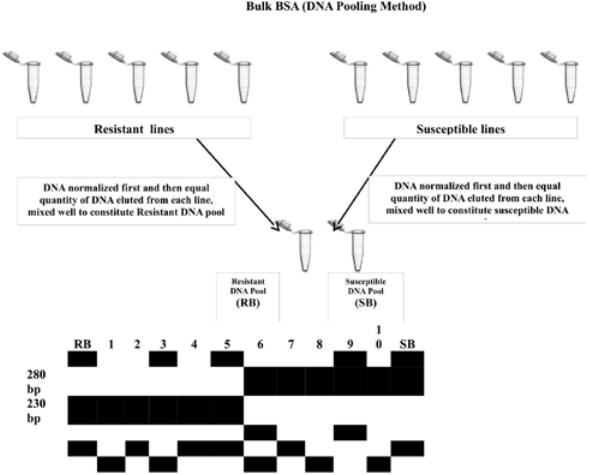
Figure 1. Figure depicting bulking sampling method where equal amount of DNA is eluted from each line after normalization and corresponding bulks generated are used for mapping genes for BGM